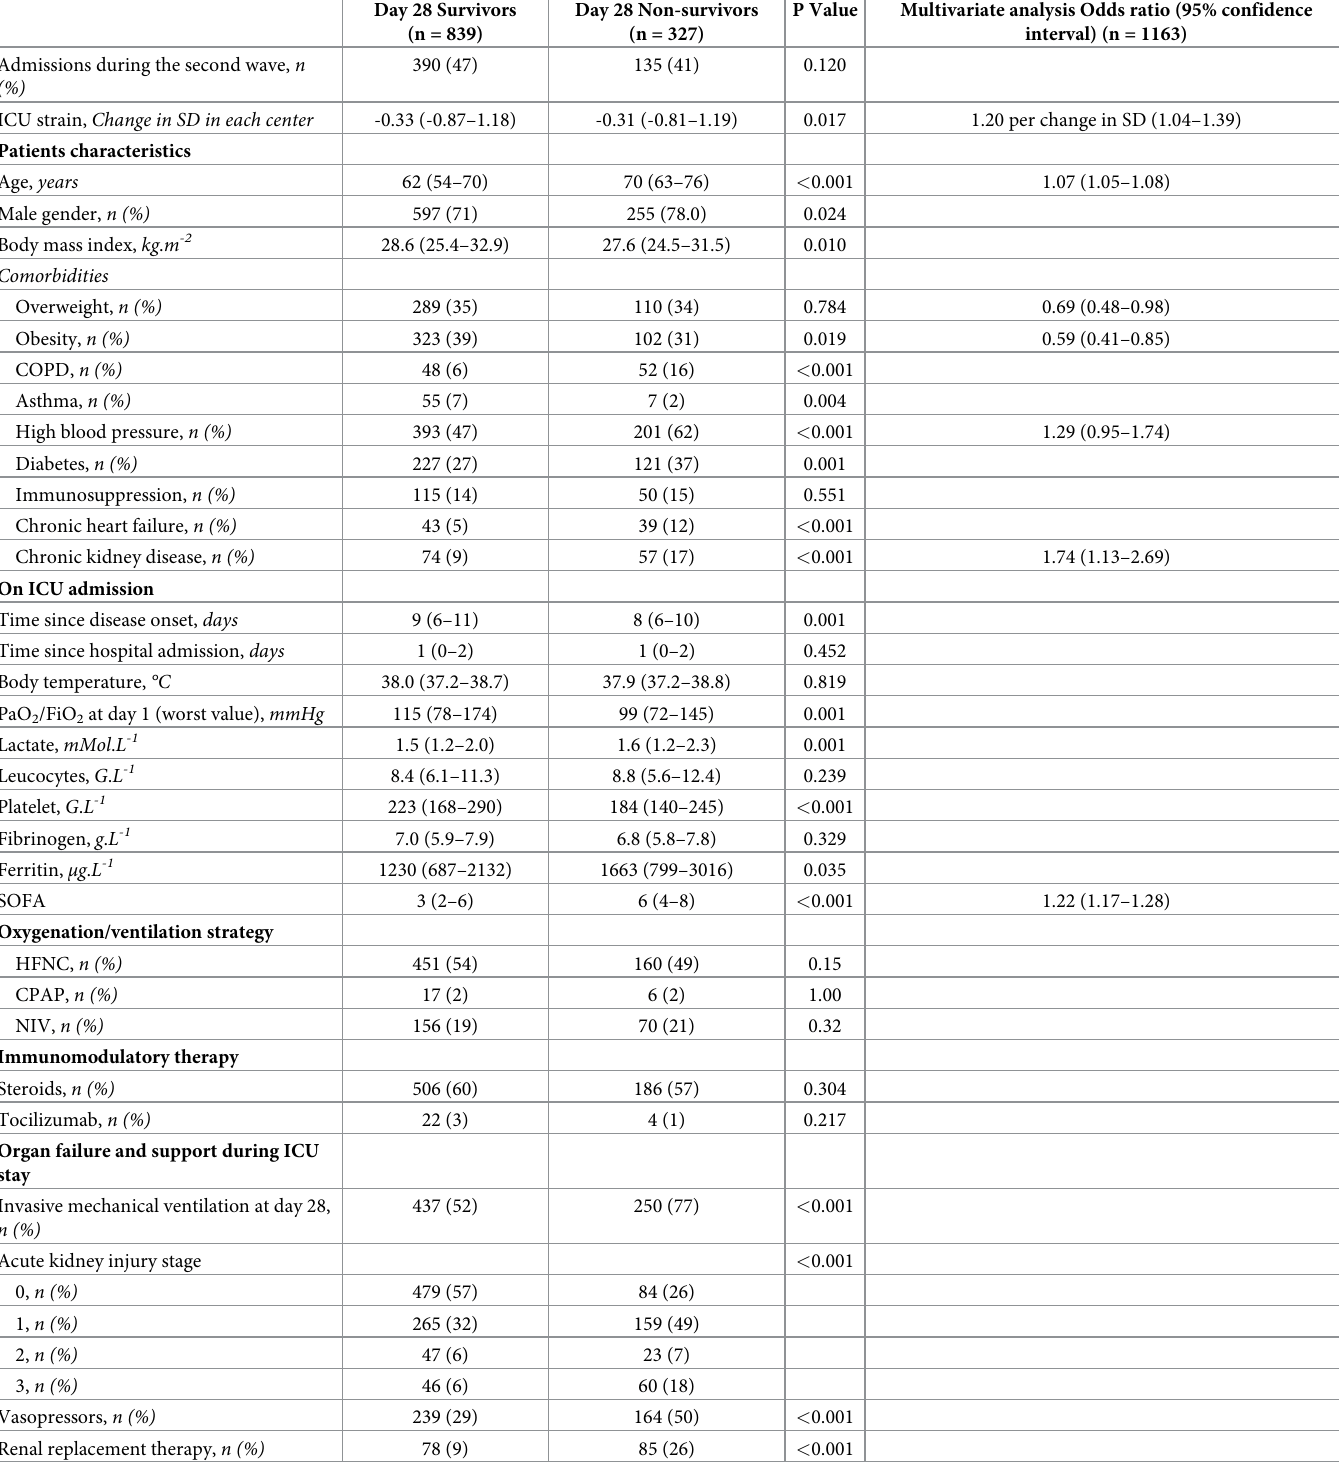
Table 3. Factors associated with mortality 28 days after admission to the intensive care unit: Univariate and multivariate